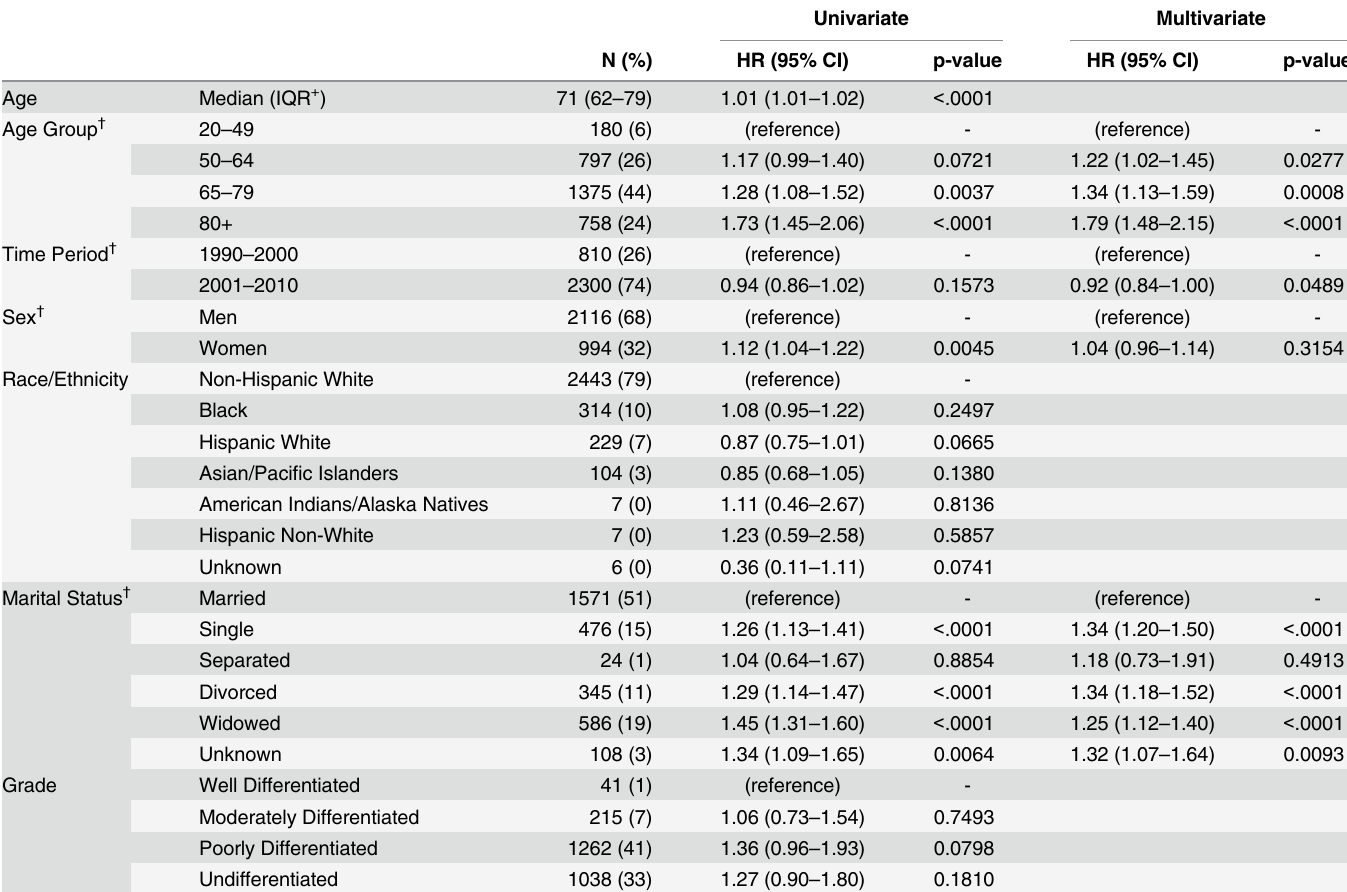
Table 3. Disease specific survival predictors, stage IV bladder